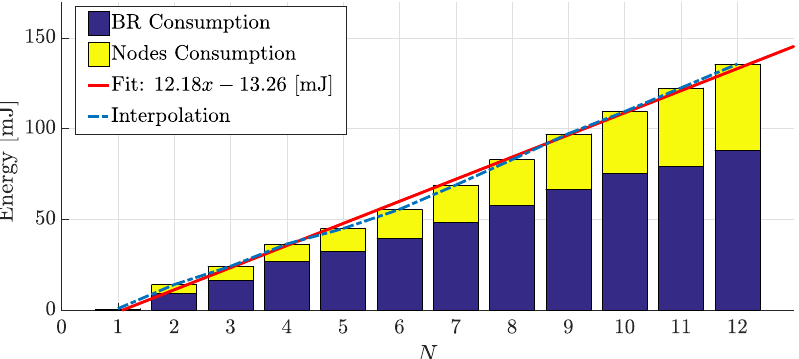
Figure 6. Energy spent by the overall network during the DAO-EBR phase with CCR set to 8 Hz (metric EN-DAO-EBR). Bars show the amount of energy spent by BR and